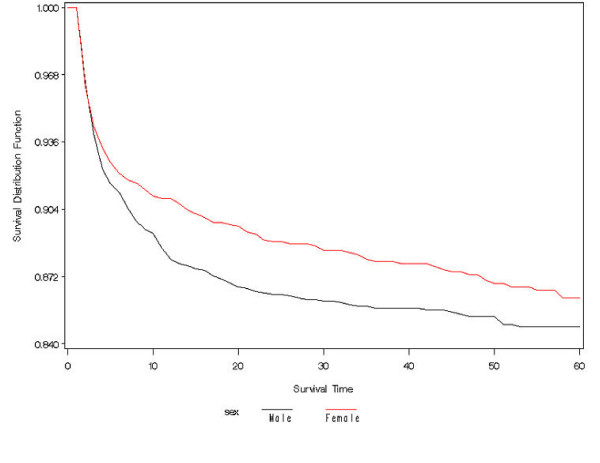
Actuarial survival curves by sex.